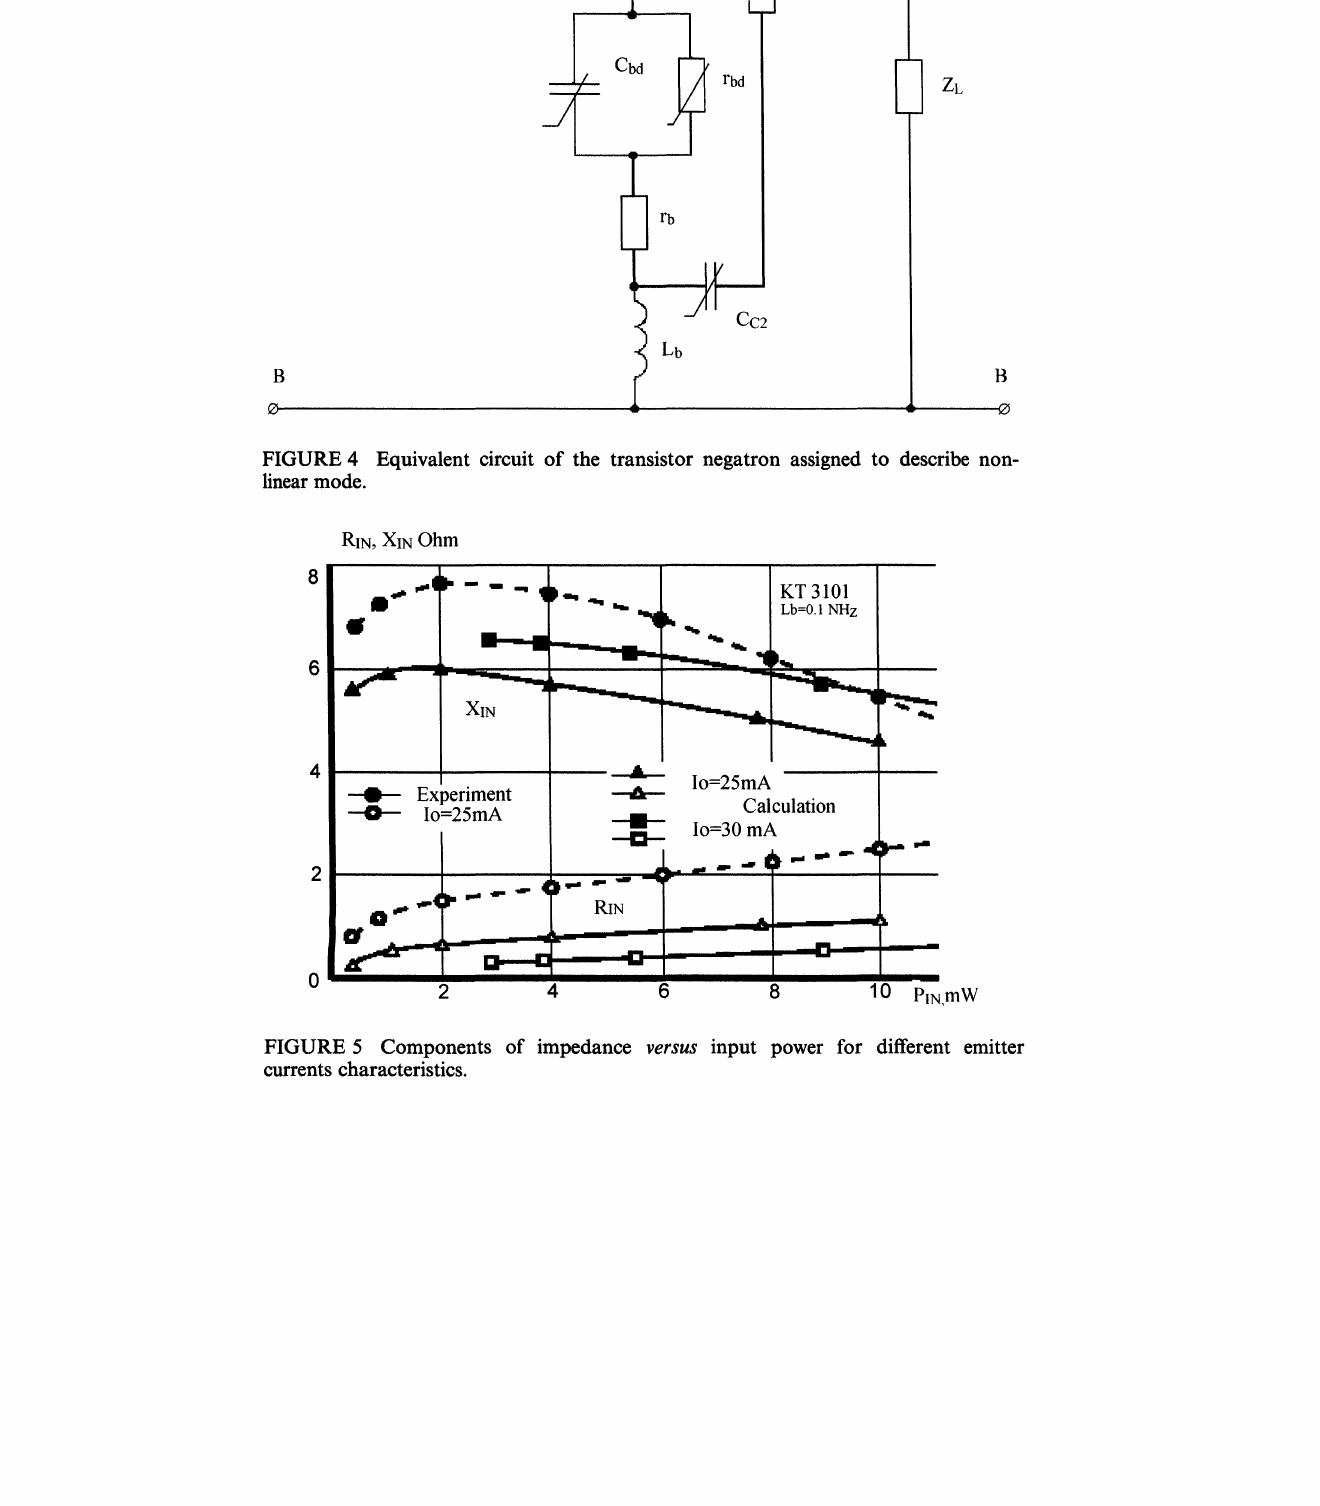
FIGURE 4 Equivalent circuit of the transistor negatron assigned to describe non- linear mode.